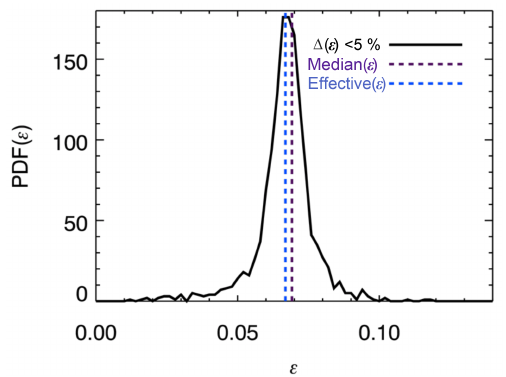
Figure 7. PDF of ε for all pixels with (cid:49)(ε) <5%, median (purple dashed line), and domain-wide effective ε derived from regression of S 0 vs. H 0 (blue dashed